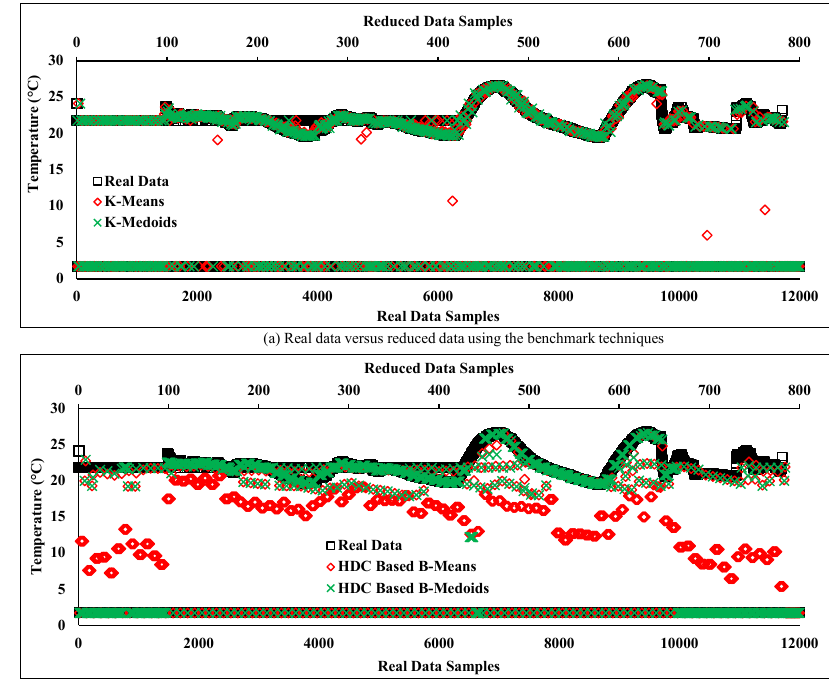
Figure 13. Performance comparison of real noisy data with reduced data using the proposed and conventional techniques versus time. ( a ) Temperature versus noisy real and reduced data based on conventional techniques; ( b ) temperature versus noisy real and reduced data based on the proposed